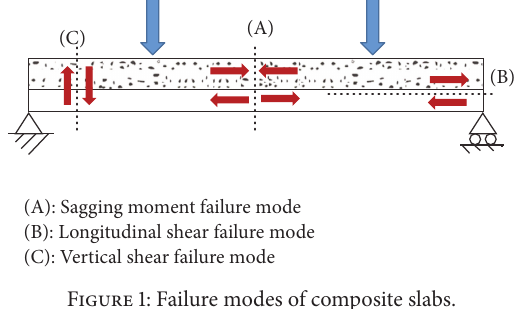
Figure 1: Failure modes of composite slabs.